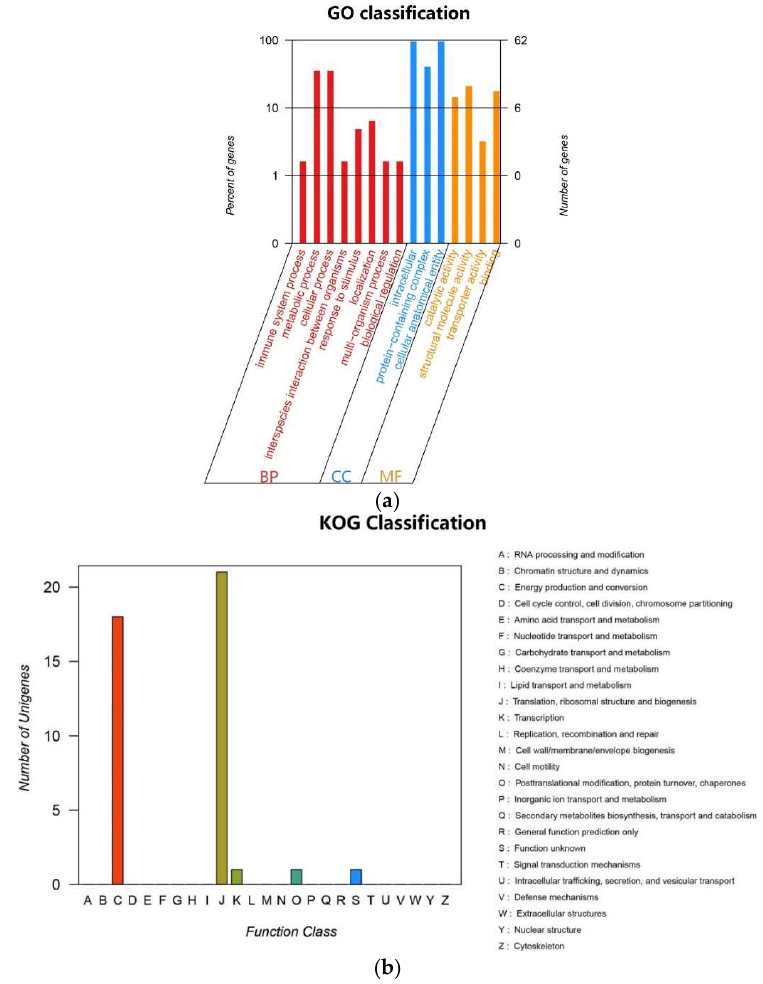
Figure 4. Classifications of gene functions of E. crus-galli var. crus-galli , E. crus-galli var. zelayensis , and E. glabrescens . ( a ) Percentages of genes matched to GO function classification. BP means biological process, CC means cellular component, and MF means molecular function. ( b ) Number of unigenes matched to KOG function